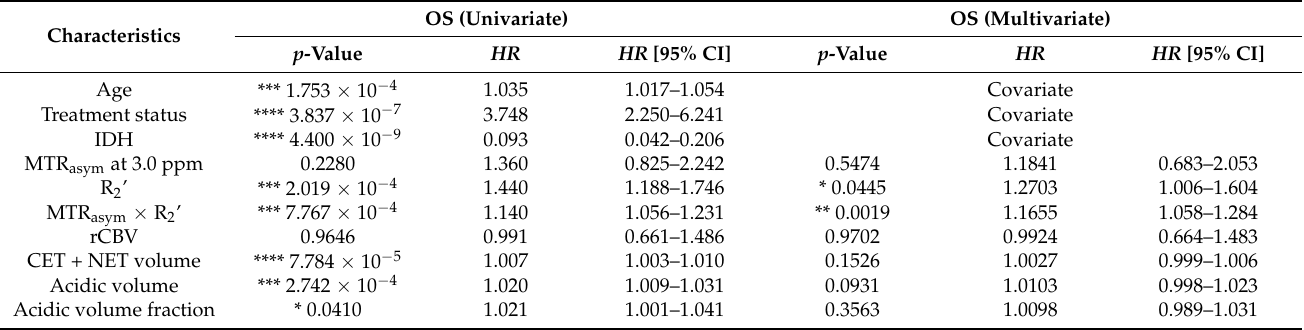
Table 2. Cox proportional-hazards model analysis of glioma residual overall survival (all